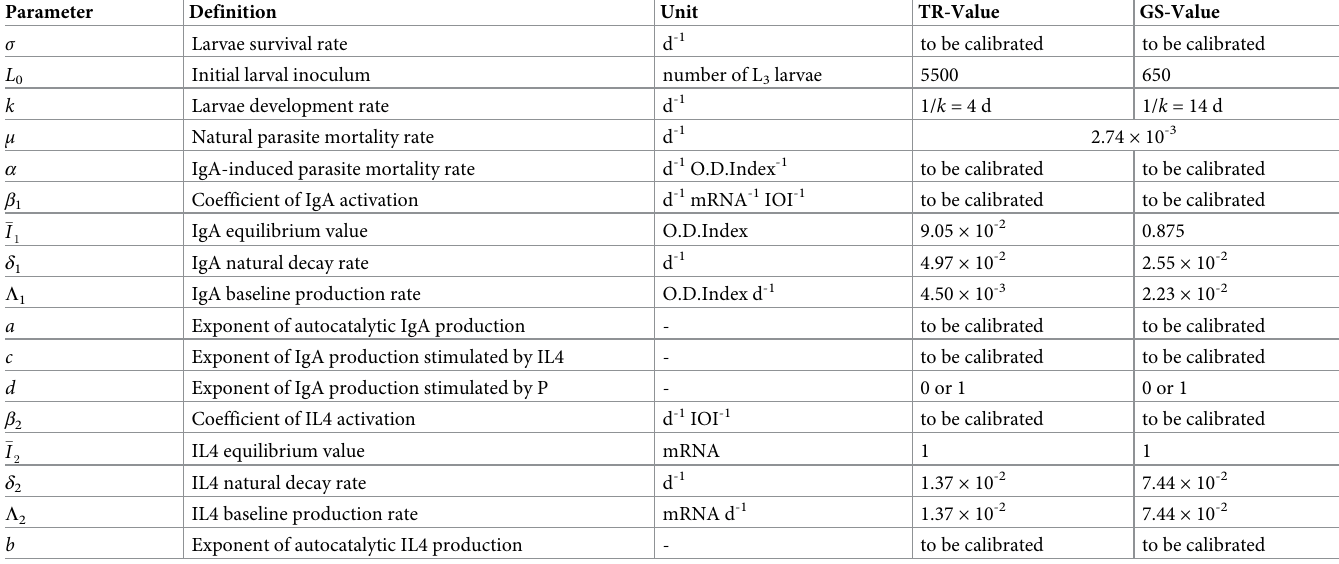
Table 1. Single infection: Model parameters, definitions, dimensions and available values for T. retortaeformis (TR) and G. strigosum (GS).